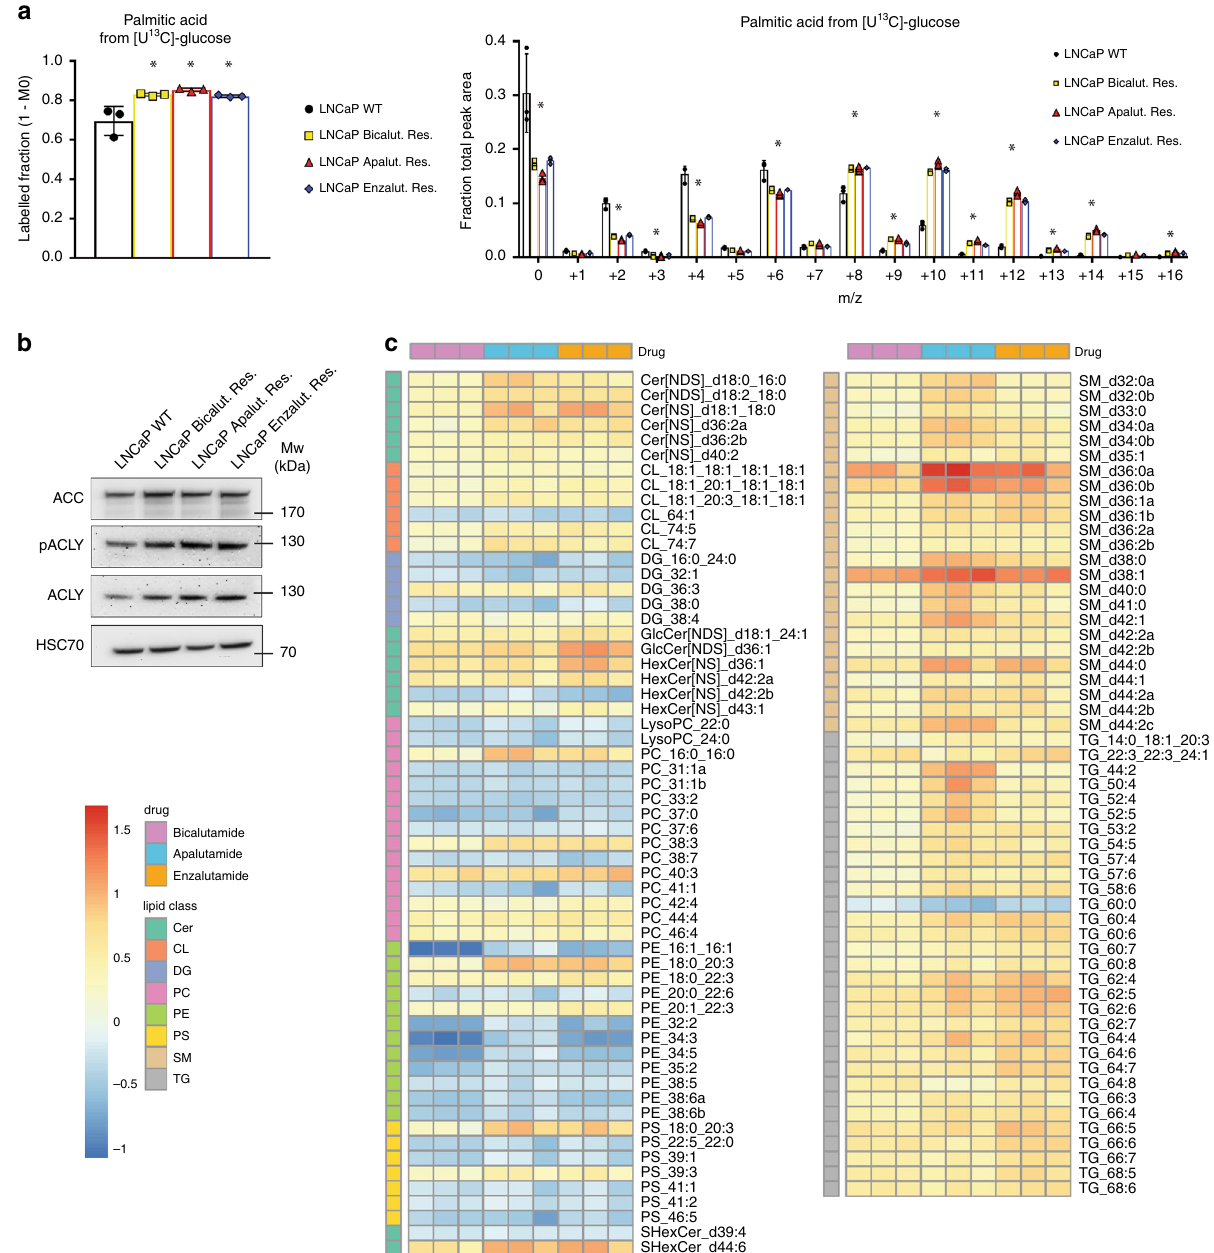
Fig. 3 Lipid metabolism is strongly dysregulated in ARI-resistant cells. a Labelled palmitate fraction derived from 13 C-glucose (left panel) and relative isotopologue distribution of palmitic acid in ARI-resistant and WT LNCaP cells following 13 C-glucose incubation for 72 h (right panel). b Western blot analysis of ACC, ACLY, and phospho-ACLY expression in WT and ARI-resistant LNCaP cells. HSC70 is used as a sample loading control. c Heatmap illustrating the steady-state levels of signi fi cantly regulated lipids in ARI-resistant cells when compared to WT LNCaP (FC > 1.5, p < 0.05 using a 1-way ANOVA with a Dunnett ’ s multiple comparisons test). Values are expressed as log(FC). a Data are presented as mean values + / − SD. a * p -value < 0.05 using a 1-way ANOVA with a Dunnett ’ s multiple comparisons test. Cer ceramide, CL cardiolipin, DG diacylglycerol, LysoPC lysophosphatidylcholine, PC phosphatidylcholine, PE phosphatidylethanolamine, PS phosphatidylserine, SM sphingomyelin, TG triglyceride. Source data are provided as a Source data